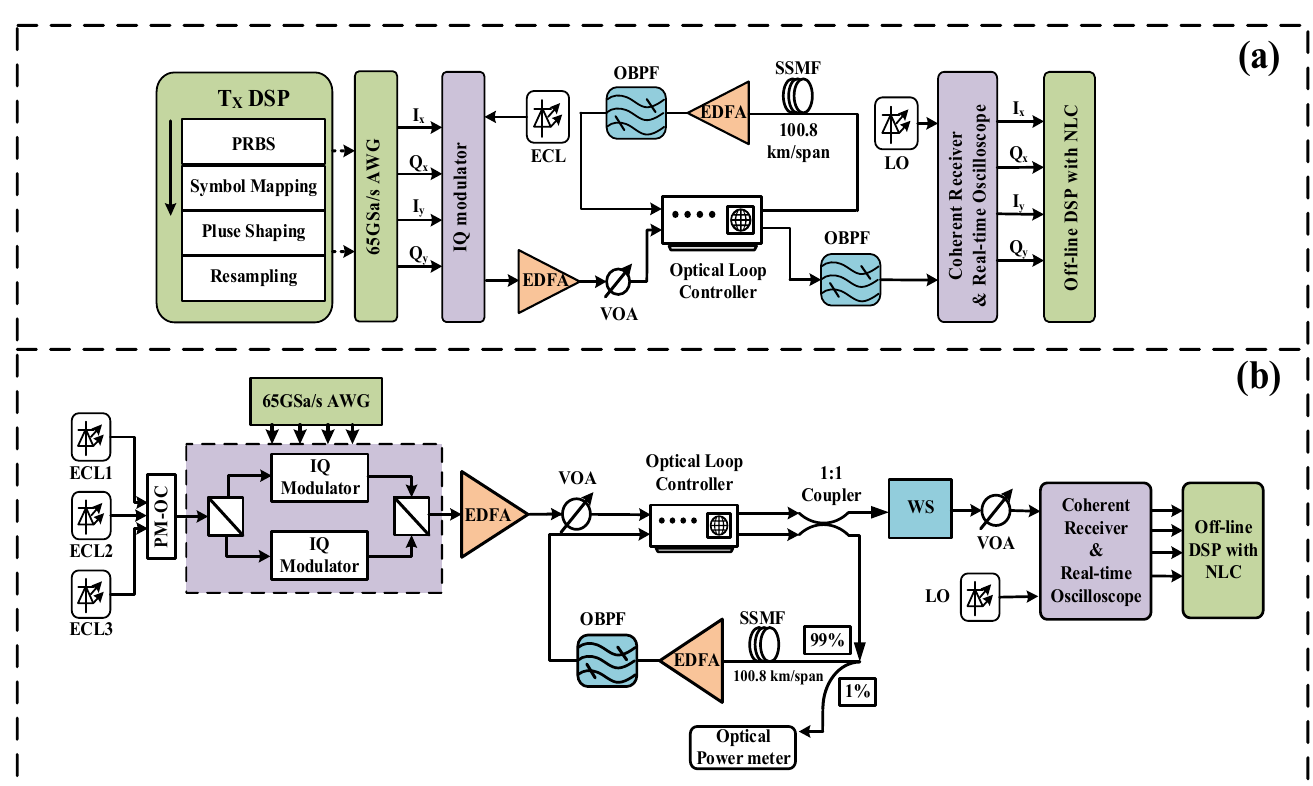
Figure 12. Experimental setup of 28 GBaud PDM-16QAM coherent optical transmission systems. ( a ) SC system; ( b ) 3-channel WDM system.